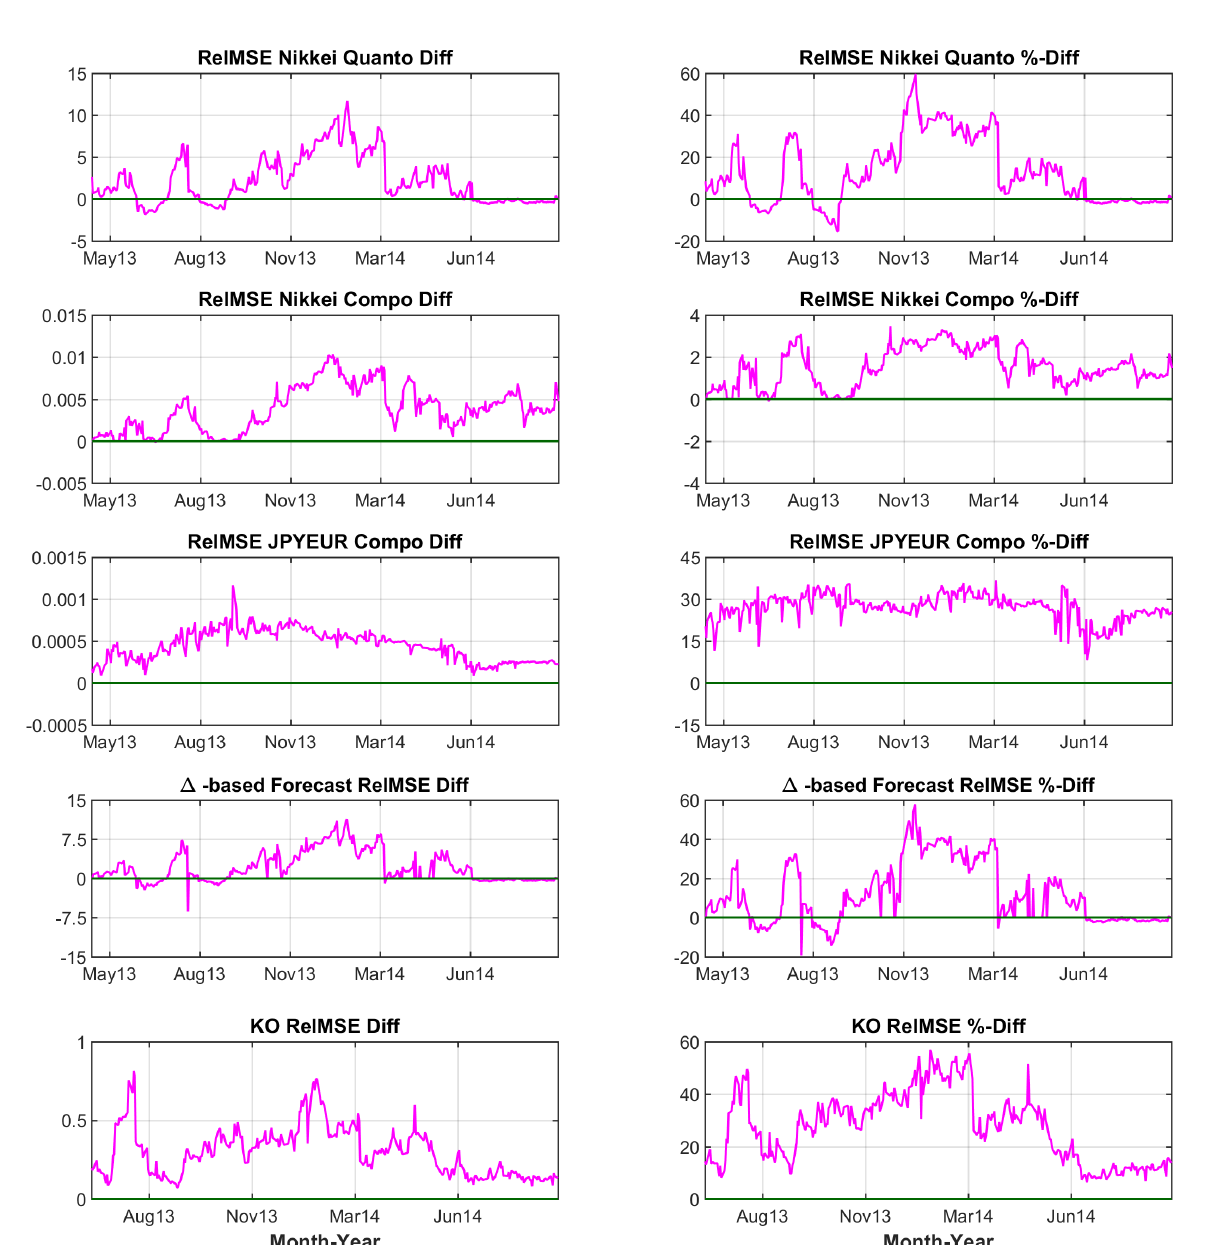
Figure 11. Quanto, compo and KO options. Top three: RelMSE-difference for the quanto Nikkei, compo Nikkei and JPYEUR options. Bottom two: RelMSE-difference of the delta-based forecasts of quanto Nikkei call prices and RelMSE-difference for KO options. Sample period for vanilla options 16 April 2013 to 15 September 2014, for KO options 19 June 2013 to 15 September 2014. Positive values indicate better performance of the NTS